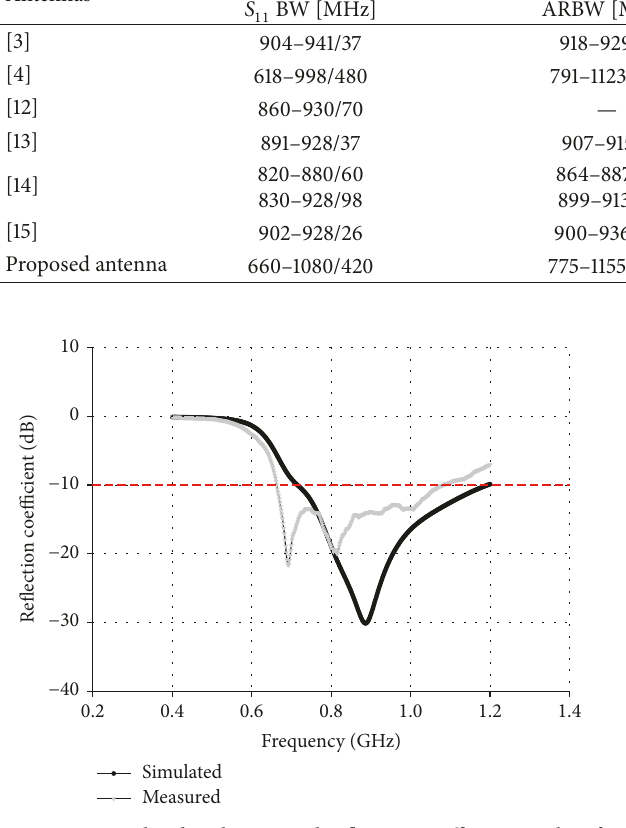
Figure 6: Simulated and measured reflection coefficient results of the manufactured antenna.